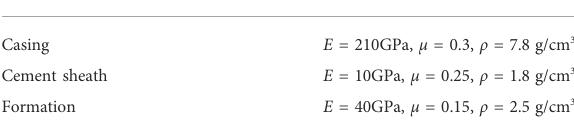
TABLE 2 Model material parameters. Element Material parameters